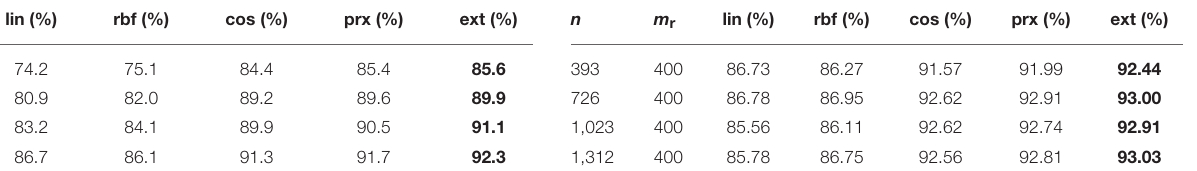
3,100,200, as functions of the geodesic =